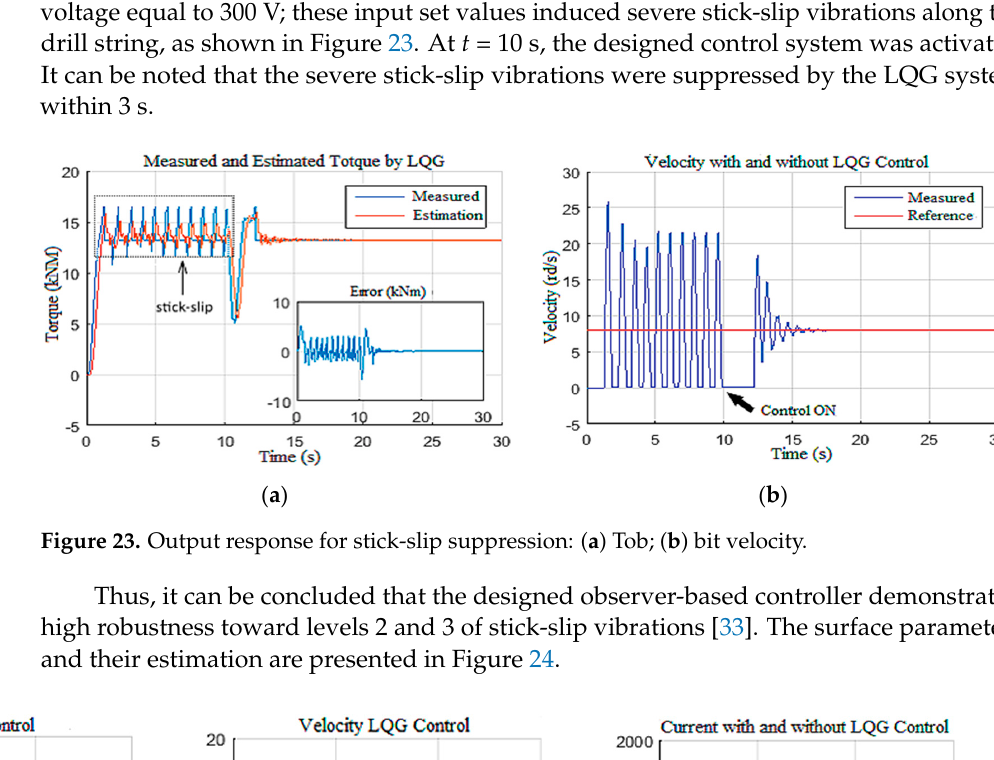
Figure 23. Output response for stick-slip suppression: ( a ) Tob; ( b ) bit velocity.